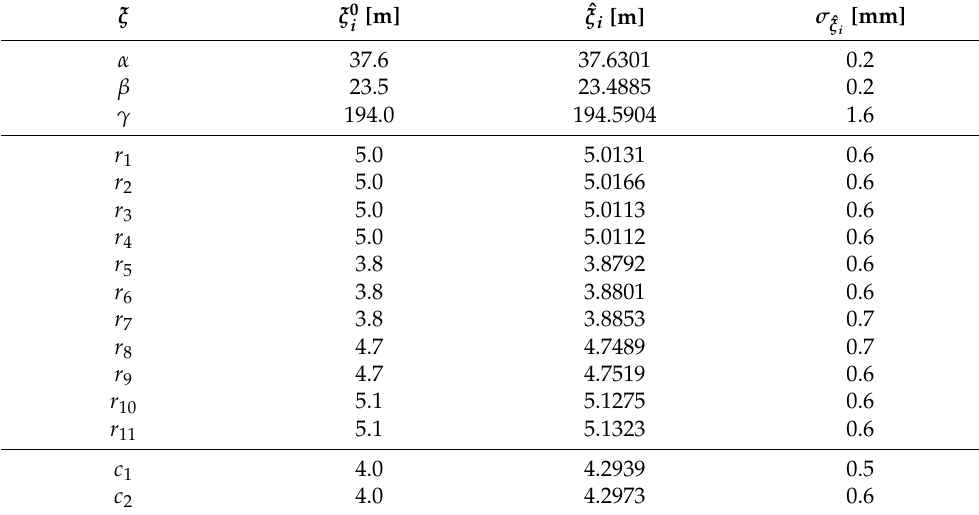
Table 4. Estimated parameters, along with the initial